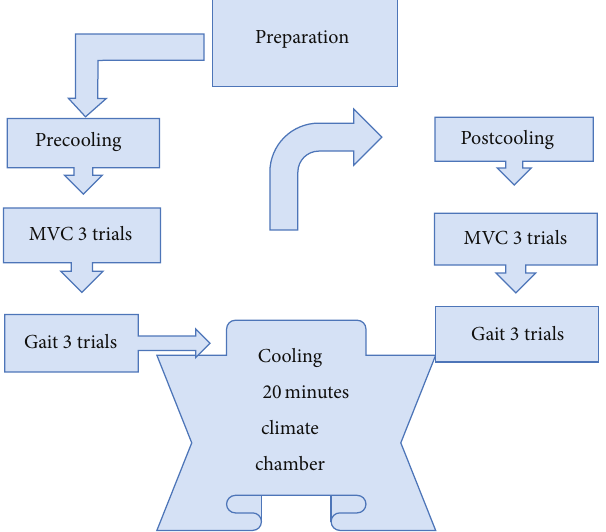
Figure 1: The procedure of experimental study: each subject performed 3 maximal voluntary contractions (MVCs) and 3 gait trailsduringthepre-andpostcoolingstages.Thesubjectsperformed precooling trials, followed by 20 min of cold water immersion at 10 ∘ C, followed by the trials immediately after cooling.